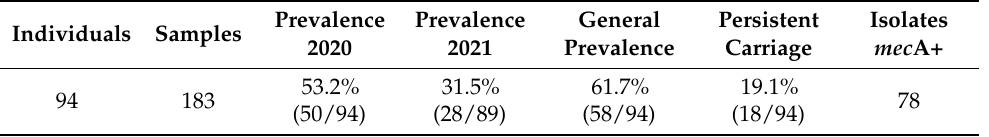
Table 1. Prevalence and individual persistence of gen mecA . Individuals